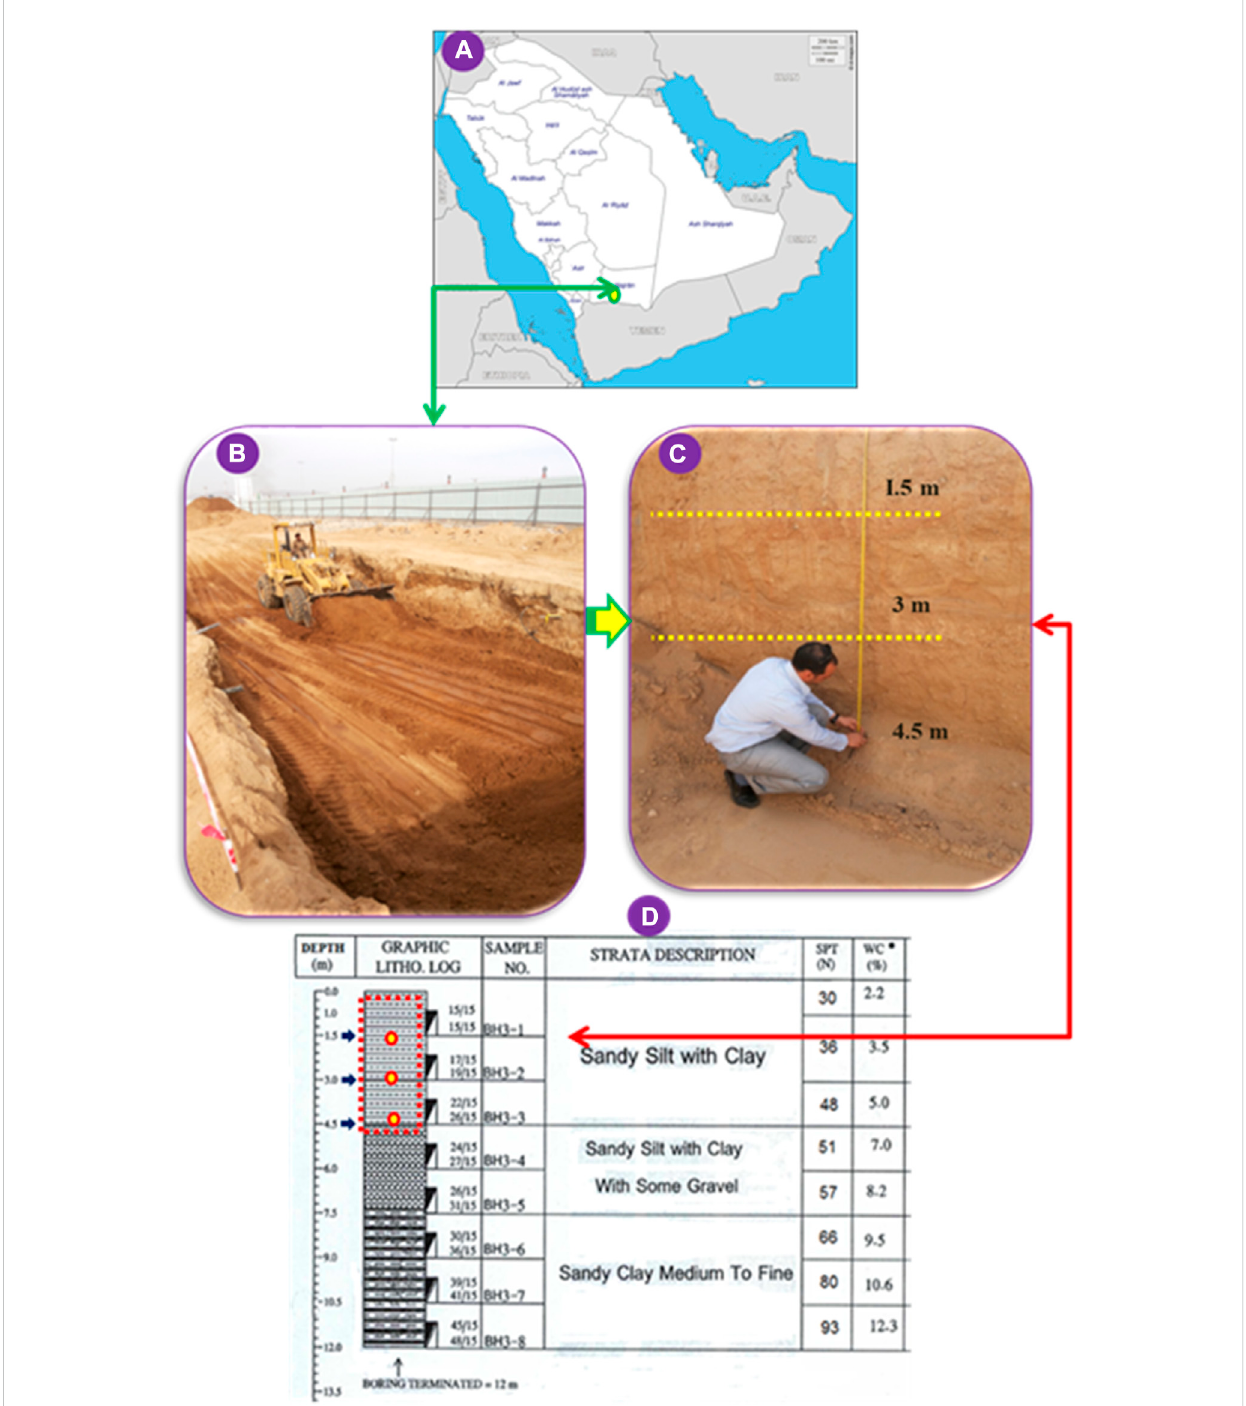
FIGURE 1 (A) Location map for soil sample area examined, (B) and (C) view of drilling and sampling at different depths, and (D) Najran soil ’ s typical soil pro fi le (borehole log) (see ditched